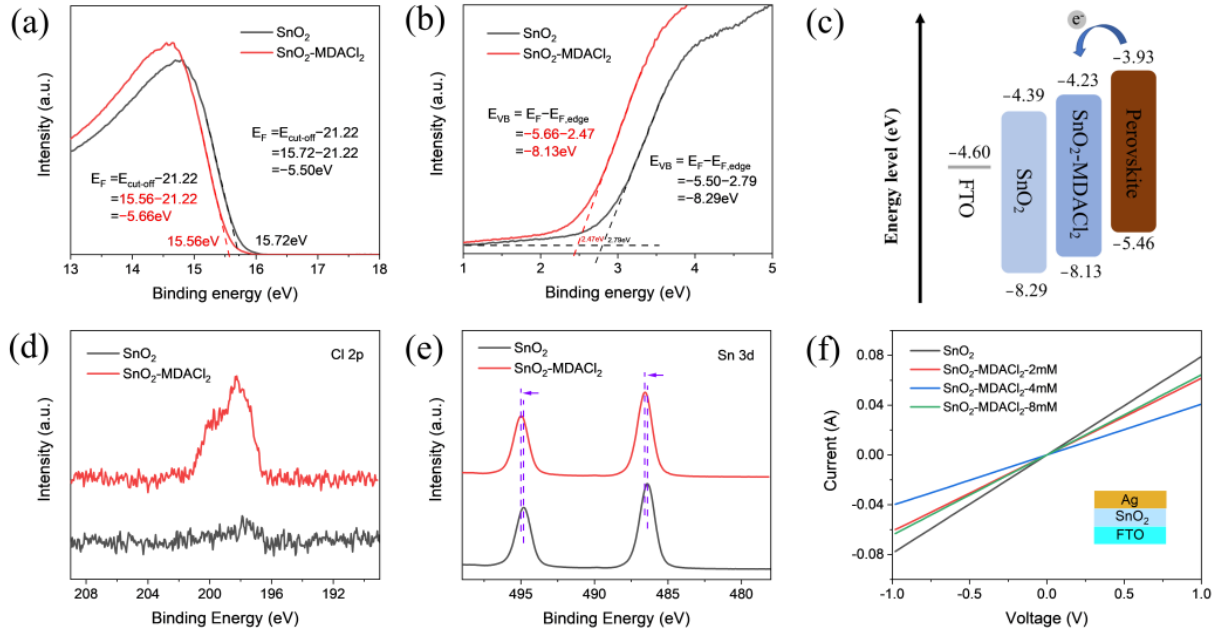
Figure 2. ( a , b ) UPS spectra of the SnO 2 , SnO 2 -MDACl 2 films. ( c ) Energy band diagram of the SnO 2 , SnO 2 -MDACl 2 , and perovskite films. The ETL energy level alignments are based on the UPS and UV − vis measurements, and the perovskite energy level alignments are based on the literature listed [60]. ( d , e ) High-resolution Cl 2p and Sn 3d XPS spectra of the SnO 2 and SnO 2 -MDACl 2 films. ( f ) Conductivity measurement curves of the FTO/SnO 2 /Au sample with different MDACl 2 doping concentrations.